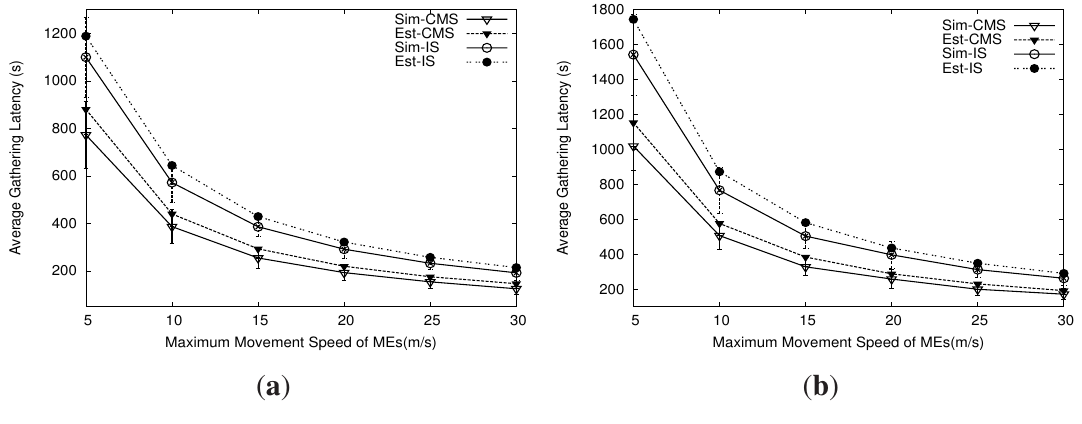
Figure 7. Average data gathering latency from estimation and simulation (mean ± standard deviation). ( a ) Configuration 1; ( b ) Configuration